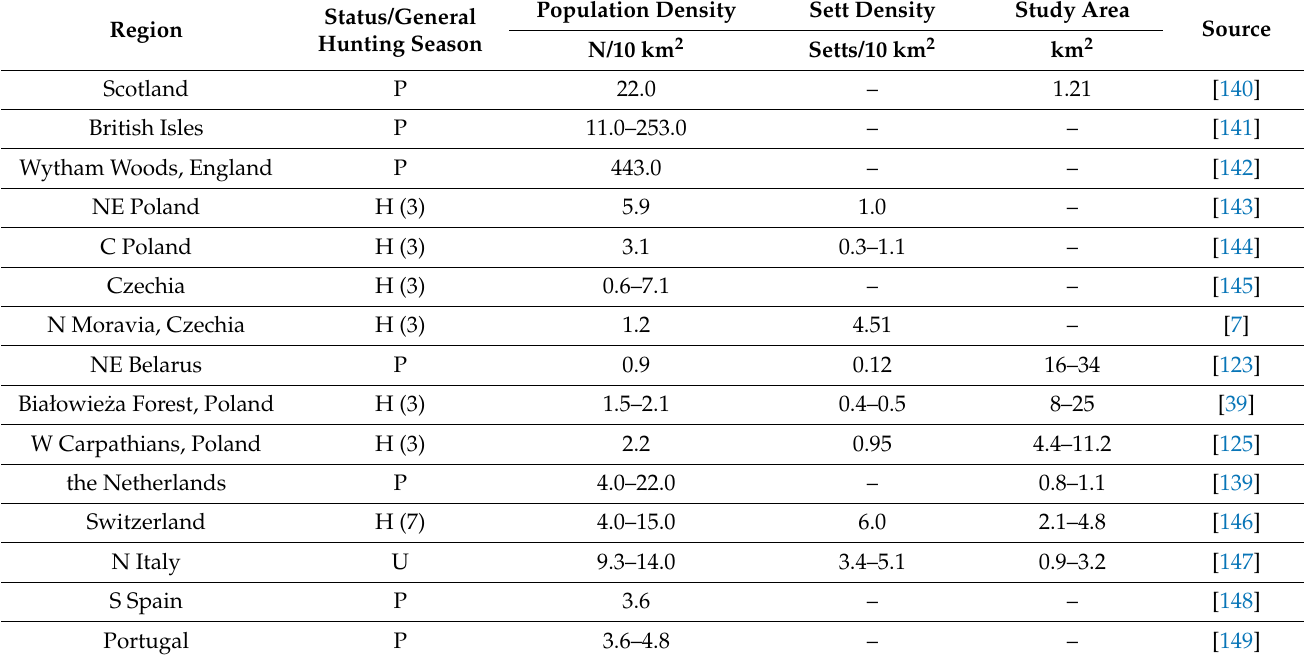
Table 2. Spatial characteristics of European badger Meles meles population in various parts of Europe. Status: P = protected all year round; H = hunted; U = unclear: game species not hunted but also not protected. The length of general hunting season given in brackets. For more detailed data see Table 1.